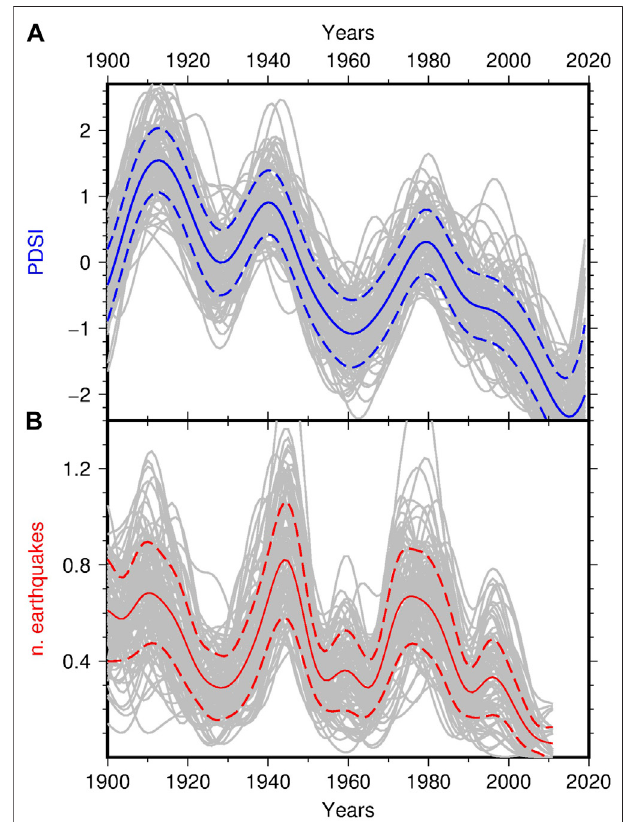
PDSI averaged over the climate zones 6 and 7 (A) and the time density of earthquakes located in Southern California (B) . The gray lines are the 1,000 smoothed curves estimated with the resampled data. The colored lines indicate the mean value in each year (continuous) and the 68% con fi dence interval (dashed).